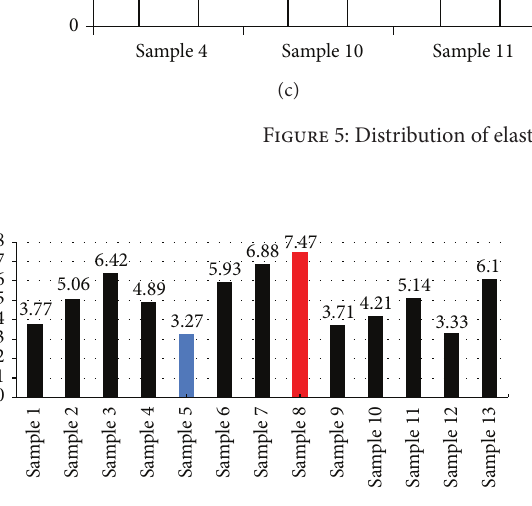
Figure 6: Distribution of area under the curve of stress-strain based on unconfined test.